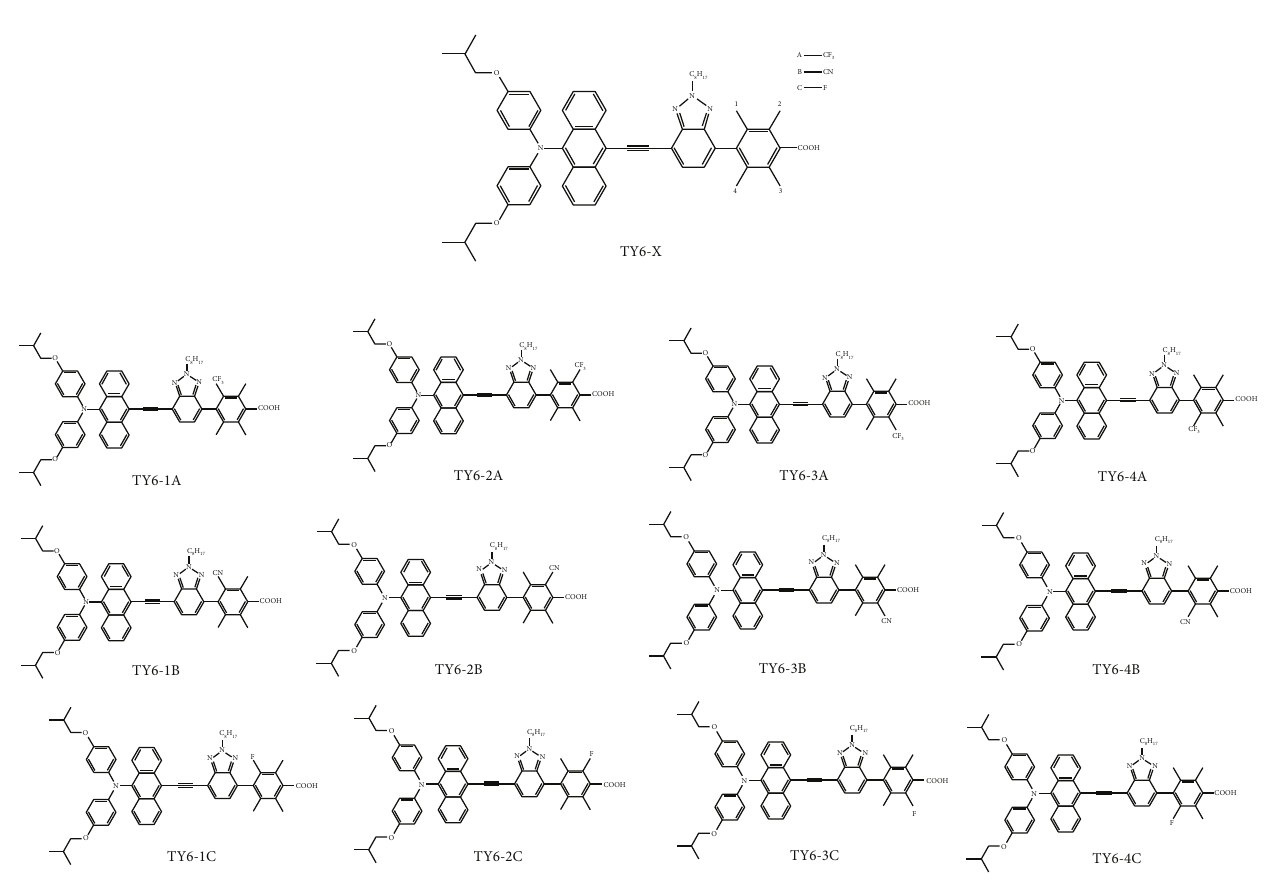
Figure 8: Chemical structures of TY6-X and the structure of each designed molecule. Table 10: Selected bond lengths (Å) and dihedral angles ( ° ) of TY6 and TY6-X.